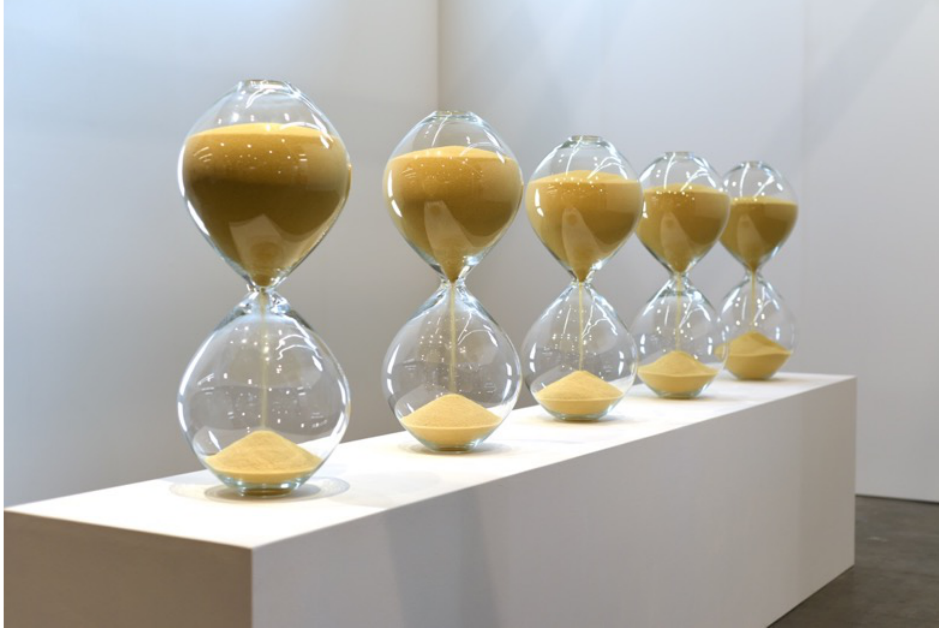
Mehdi-Georges Lahlou, The Hourglasses , 2015. Mold-blown glass and couscous. Series of 5, +/- 73 by 30 x 30 centimeters each. Galerie Transit, Mechelen, Belgium, and Galerie Rabouan Moussion, Paris, France. Image courtesy of the